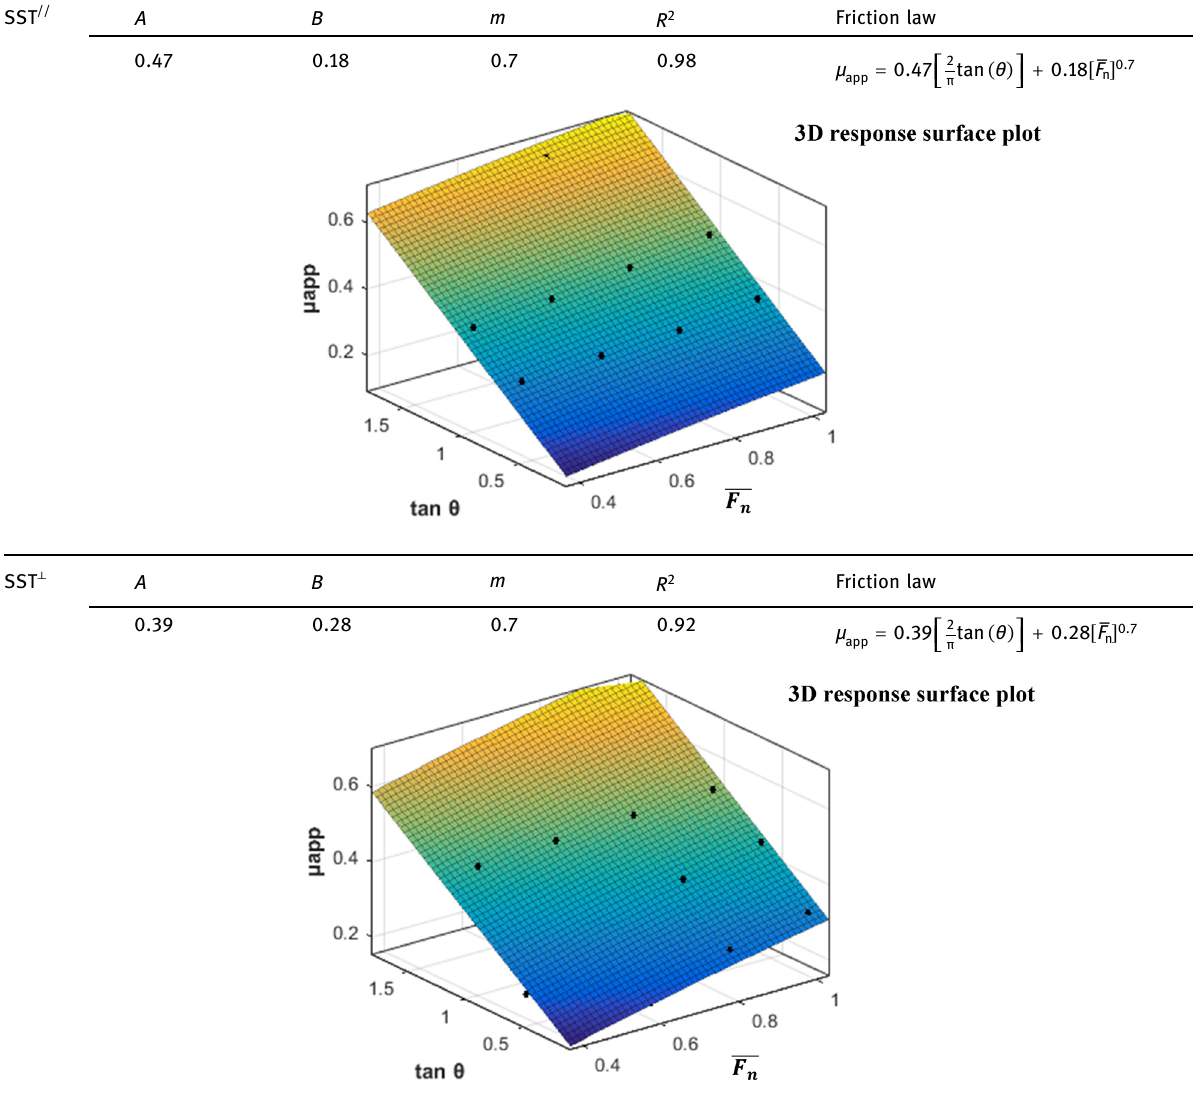
Table 2: Friction law parameters and correlation coe ffi cients obtained by RSM SST // A